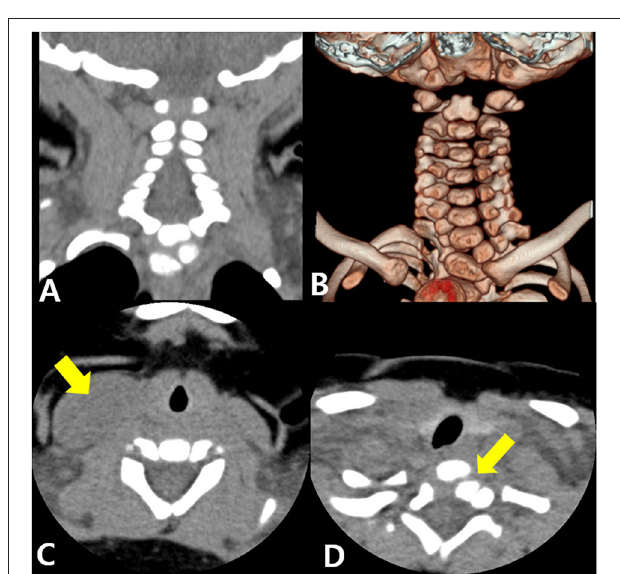
CMT accounts for most cases of torticollis in infants (3, 8, 9).